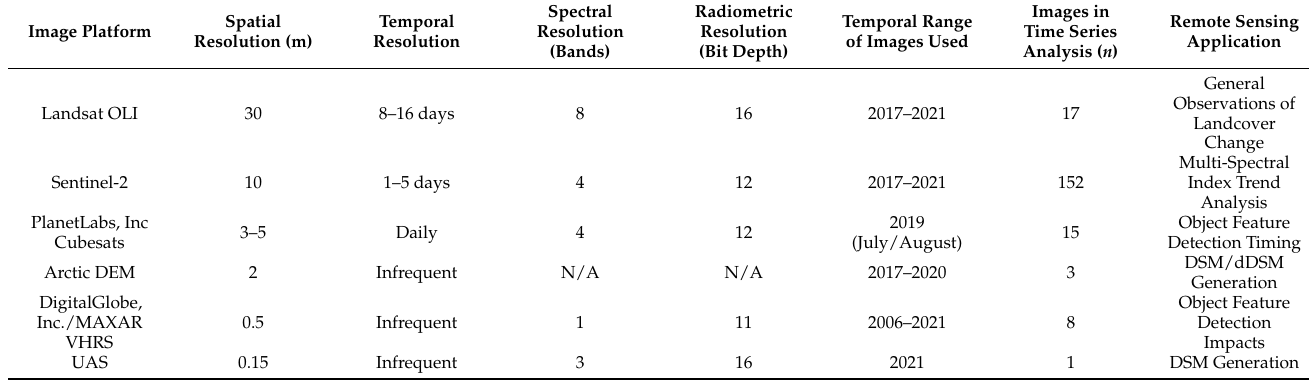
Table 1. Multi-dimensional remote sensing image platforms, spatial resolution, temporal resolution, spectral resolution, radiometric resolution, temporal range of images used, number of images in the time series analysis, and the application for detecting and quantifying beaver-induced permafrost degradation at the Swan Lake Creek study site, Seward Peninsula, Alaska. Image